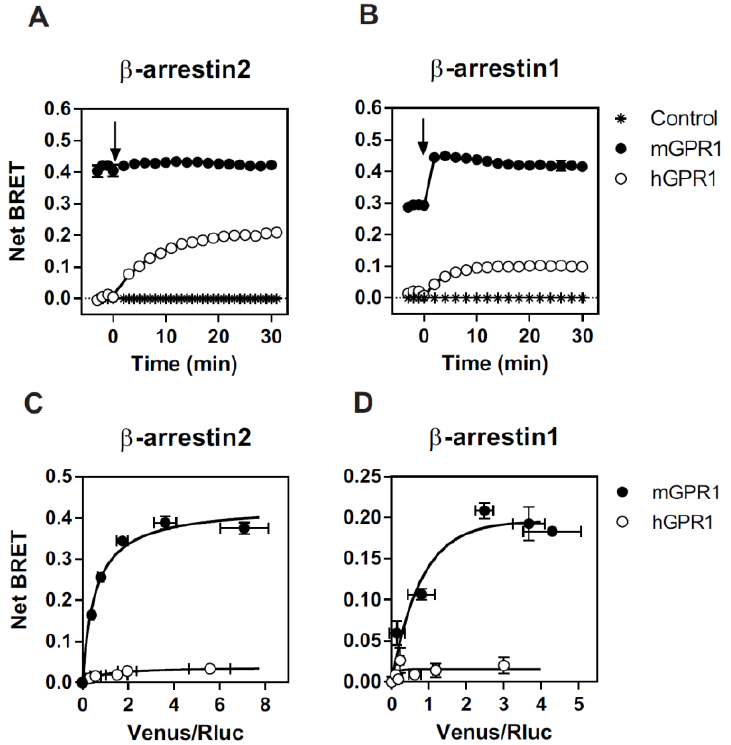
Figure 1. Mouse GPR1 constitutively interacts with β -arrestins: ( A , B ) real-time measurement of BRET signal in HEK293T cells expressing β -arrestin2- R Luc ( A ) or β -arrestin1- R Luc ( B ) in combination with hGPR1-Venus ( ○ ) or mGPR1-Venus ( ● ), in basal conditions and after stimulation with 100 nM chemerin. ( C , D ) BRET titration curves obtained with HEK293T cells transfected with a constant amount of β -arrestin2- R Luc ( C ) or β -arrestin1- R Luc ( D ) and increasing amounts of hGPR1-Venus ( ○ ) or mGPR1-Venus ( ● ). Results are expressed as Net BRET corresponding to the difference between the BRET signal measured between the donor and the acceptor pair and the BRET signal measured with the donor only. Data represent the mean ± SEM of at least three independent experiments.